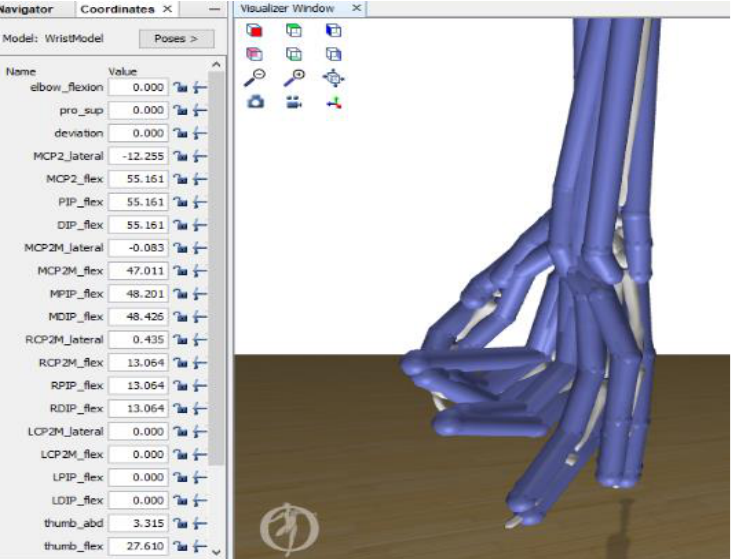
Figure 7 . Screenshot of the software application displaying the degrees of freedom of the model used in Opensim.